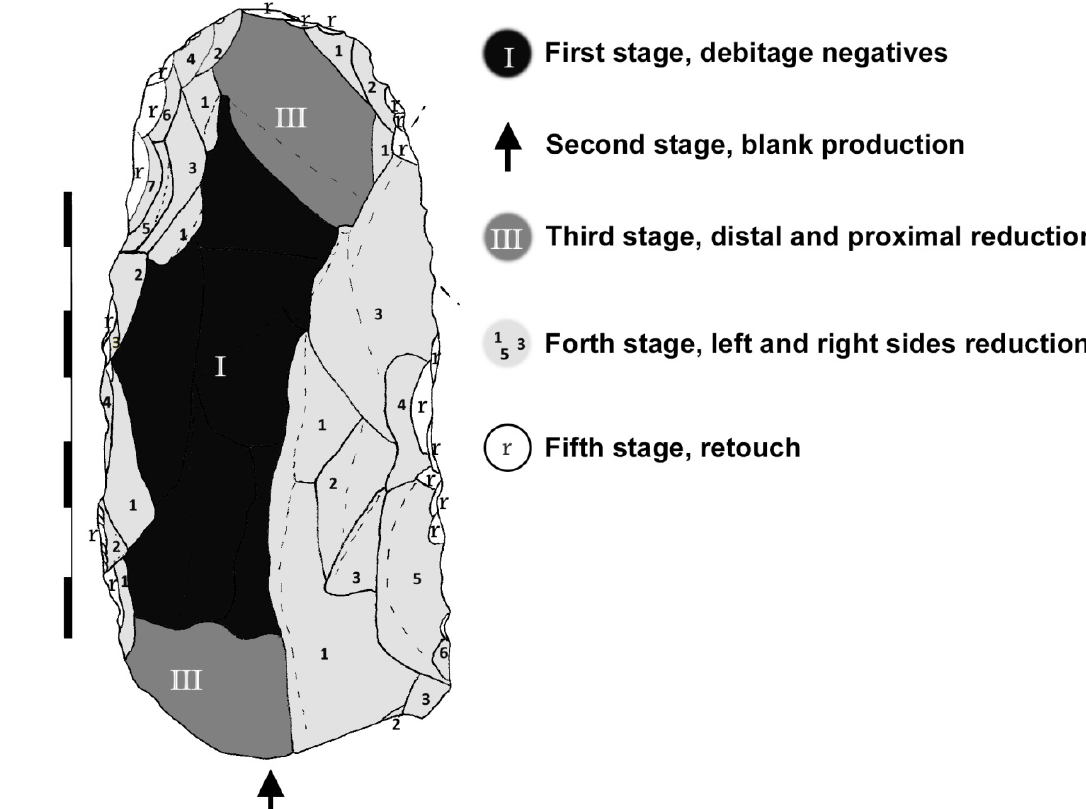
Figure 8. Diachronic organization of artifact negatives. Limace found at Lapa de Taquaraçu archaeological site. Scale bar correspond to 7 cm. Schematic drawing by João Carlos Moreno da Sousa.